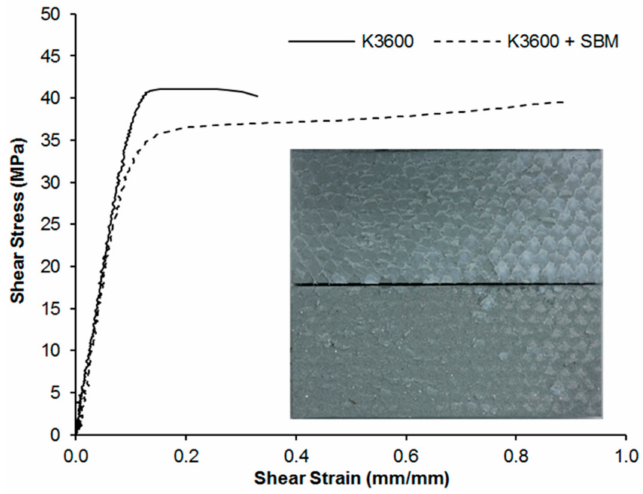
Figure 10. Representative shear stress–strain curves for the neat and toughened resin